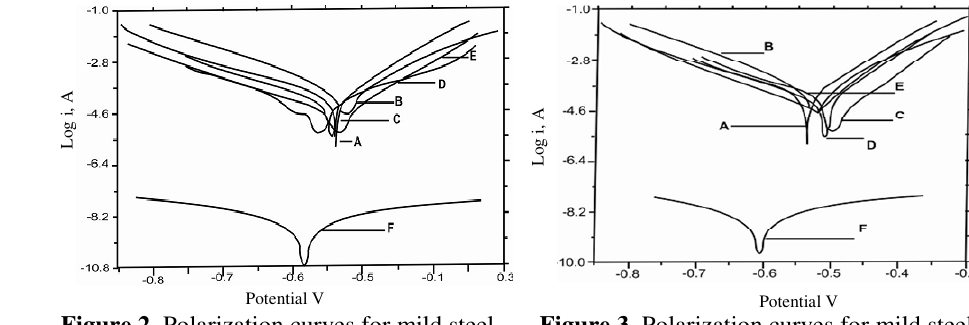
Figure 3. Polarization curves for mild steel corrosion in sulphuric acid with AV (A-blank, B-0.02%AV, C-0.04%AV, D-0.06%AV, E-0.08%AV,